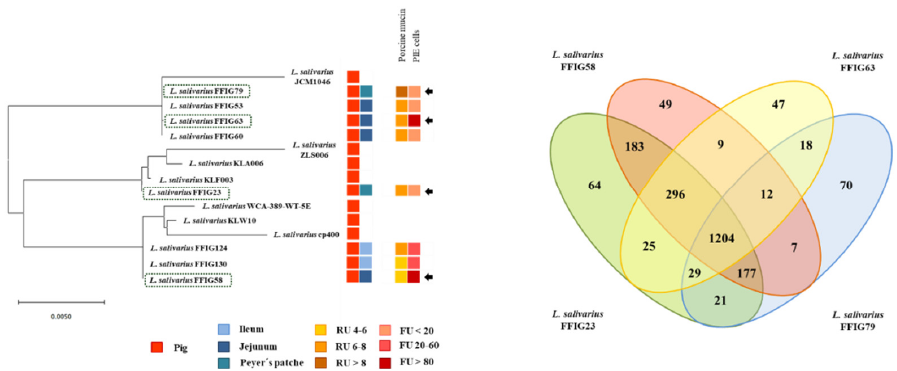
Figure 8. Genomic comparison of Ligilactobacillus salivarius strains isolated from the intestinal mucosa of wakame-fed pigs. Four “adhesion phenotypes” were defined according to the ability of L. salivarius FFIG strains to adhere to porcine mucins, as well as to porcine intestinal epithelial (PIE) cells. The phylogenetic tree constructed with the MLST analysis of the genes parB , rpsB , pheS , nrdB , groEL , and ftsQ is used to show the strains. L. salivarius FFIG23, FFIG58, FFIG63, and FFIG79 were compared. Venn diagram depicts the number of unique genes in each genome and the numbers of genes sheared by the strains.